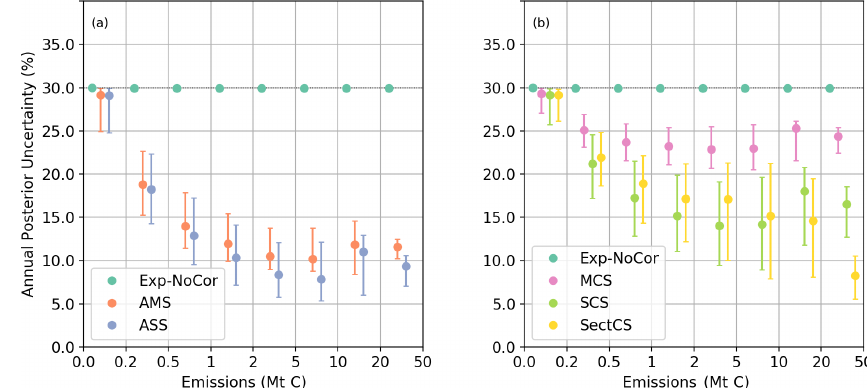
Figure 5. Distribution of the posterior uncertainties in annual CO 2 emissions for different OSSEs. The results are binned according to the clump annual emission with bin limits given on the x axis of the figure. Dots and error bars are the median and interquartile range of posterior uncertainty. Numbers at the figure top indicate the number of clumps and the percentage of clump emission within that